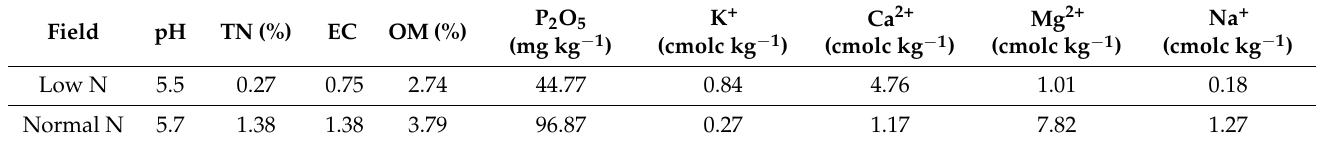
Table 1. Soil mineral elements composition and hydrogen